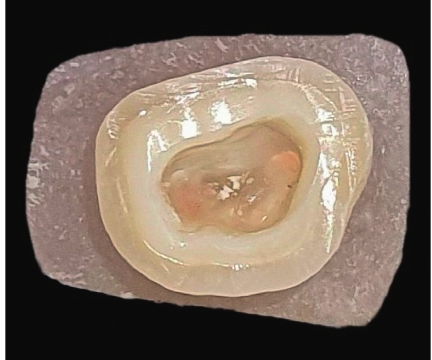
Figure 2: Prepared molar tooth specimen.